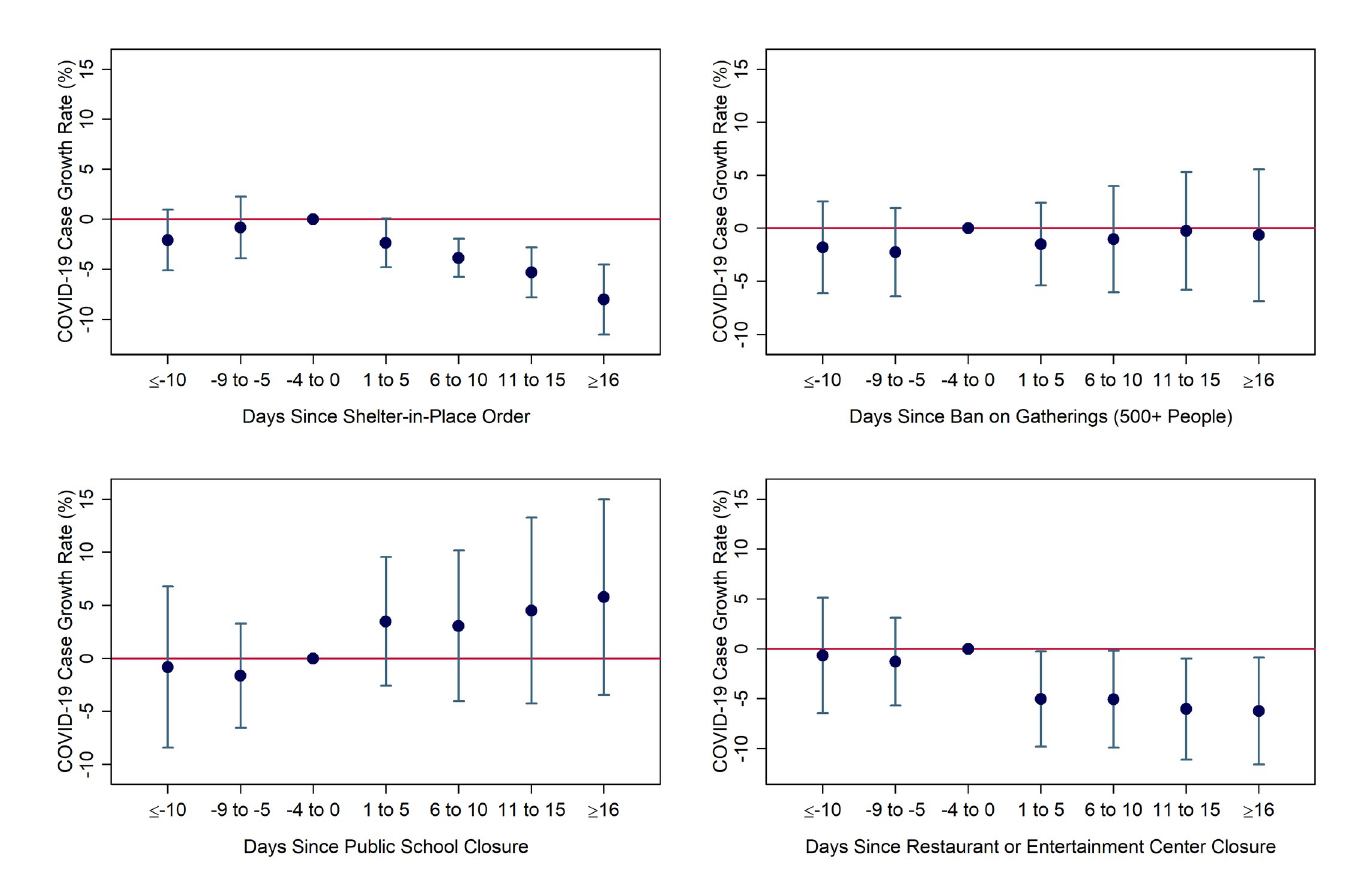
Fig 2. Estimated impacts of social-distancing measures over time from event-study model. Notes: Coefficients and 95% confidence intervals were derived from authors’ event-study regression using daily county-level data from March 5-April 25 from the South and Midwest Census Regions, weighted by population. Day and county fixed effects were included. Standard errors were heteroskedasticity-robust and clustered by